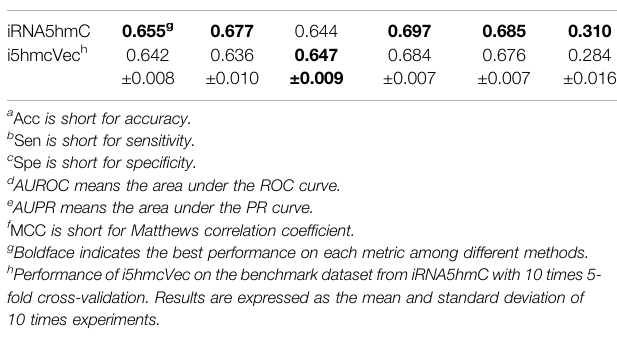
TABLE 3 | Performance of i5hmcVec and iRNA5hmC on the benchmark dataset from iRNA5hmC.